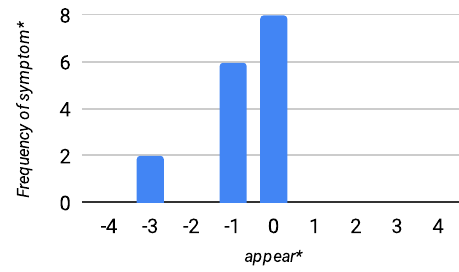
Fig. 4 Distribution of lemma of SYMPTOM with respect to conjugations of verb at node = 0. Verb appear with symptom in English core corpus, standard deviation from mean, μ = − 1.5, σ = 0.93. Starred items denote noun and verb forms rather than tokens.